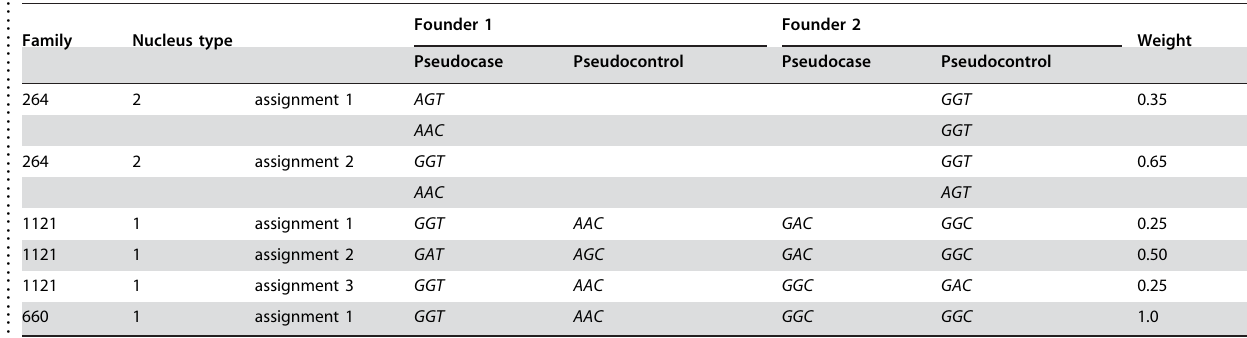
Table 4. Pedagogic example of a reconstruction table with only three nuclei represented in it. See explanation in the main text. .. ... .... ... ... .... ... ... .... ... ... .... ... ... .... ... ... .... ... ... .... ... ... .... ... ... .... ... ... .... ... ... .... ... ... .... ... ... .... ... ... .... ... ... .